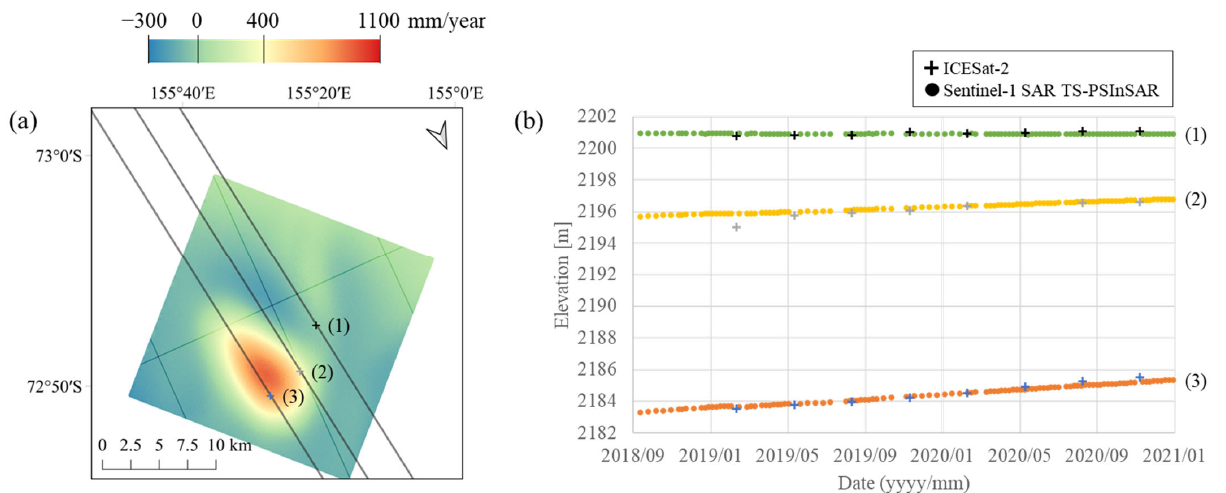
Figure 13. The time series of TS ‐ PSInSAR results. ( a ) is a map showing extraction points and obser ‐ vation track of ICESat ‐ 2. The track ID for ICESat ‐ 2 is 695. The background image is the mean LOS velocity map from September to December 2020, which is the same as Figure 12h; ( b ) represent the elevation according to time at points marked with the same color in ( a ).